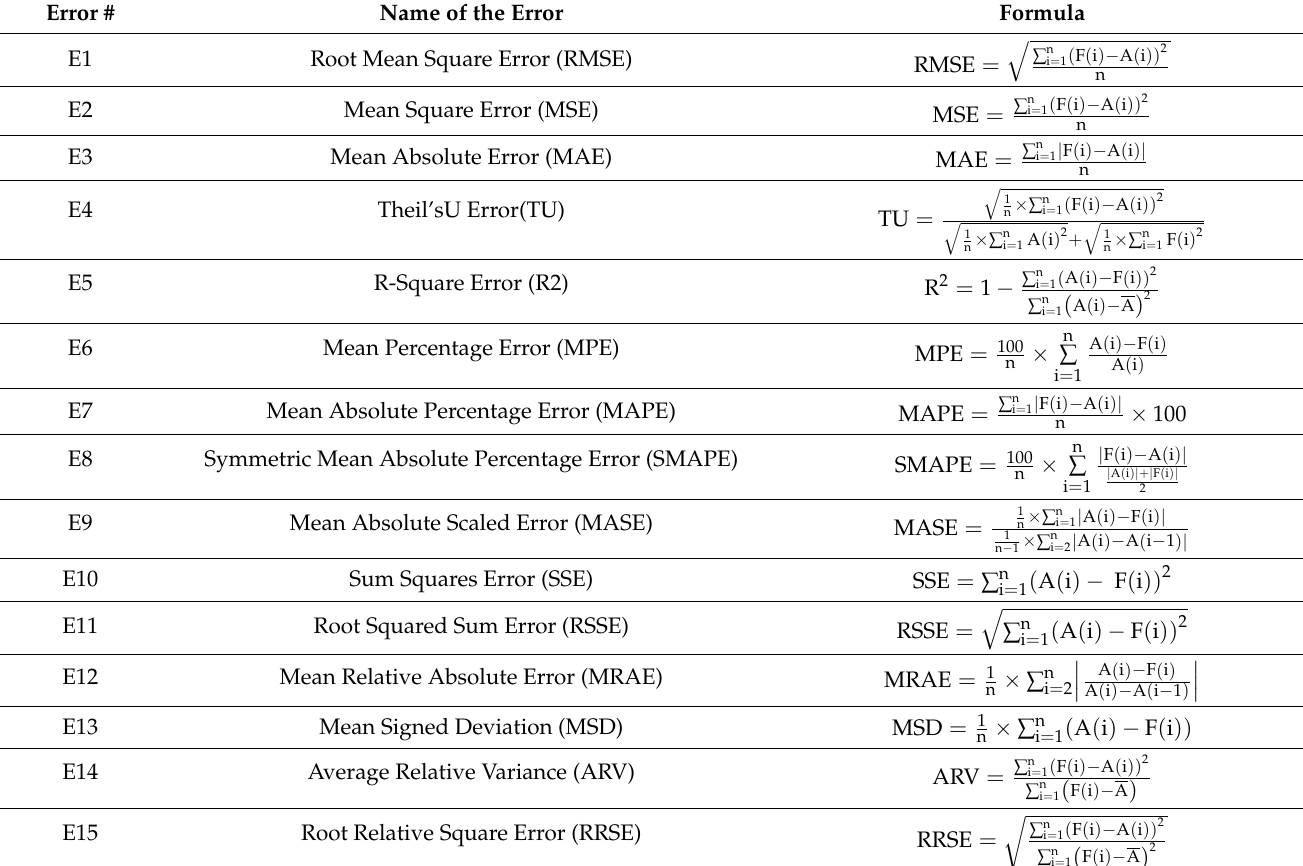
Table 6. FifteenError Metrics with